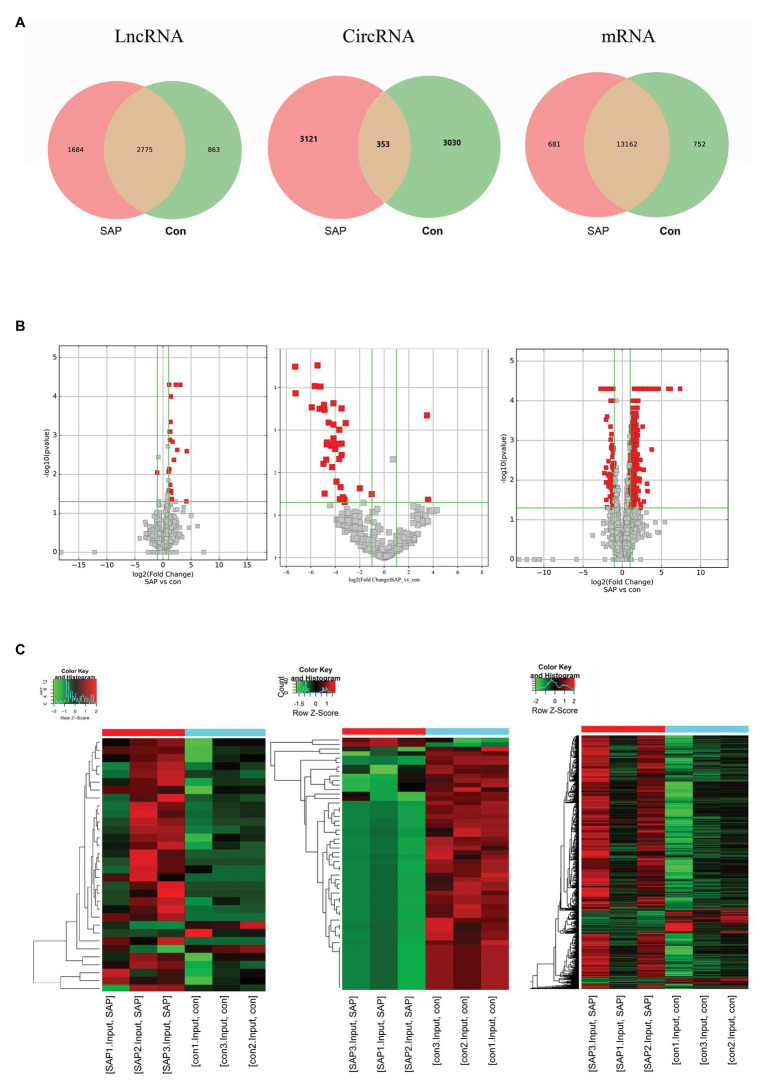
Differential expression of lncRNA, circRNA and mRNA. (A) The specific lncRNAs, circRNAs, and mRNAs shared between SAP group and control (con) group. The red points showed the up-regulated lncRNAs, circRNAs, mRNAs. The green points showed the down-regulated lncRNAs, circRNAs, and mRNAs. (B) The volcano diagrams showed the DE lncRNAs, circRNAs and mRNAs in the pancreatic head tissue of the three pairs of SAP group and control group, respectively. (C) Heatmap showing DE lncRNAs, circRNAs and mRNAs from pancreatic tissues of SAP mice compared to pancreatic tissues of control mice, respectively. Row and column represent DE lncRNA/DE circRNA/DE mRNA transcripts and tissue samples, red color represents up-regulated DERNAs, green color represents down-regulated DERNAs, and heavier color represents higher fold change.